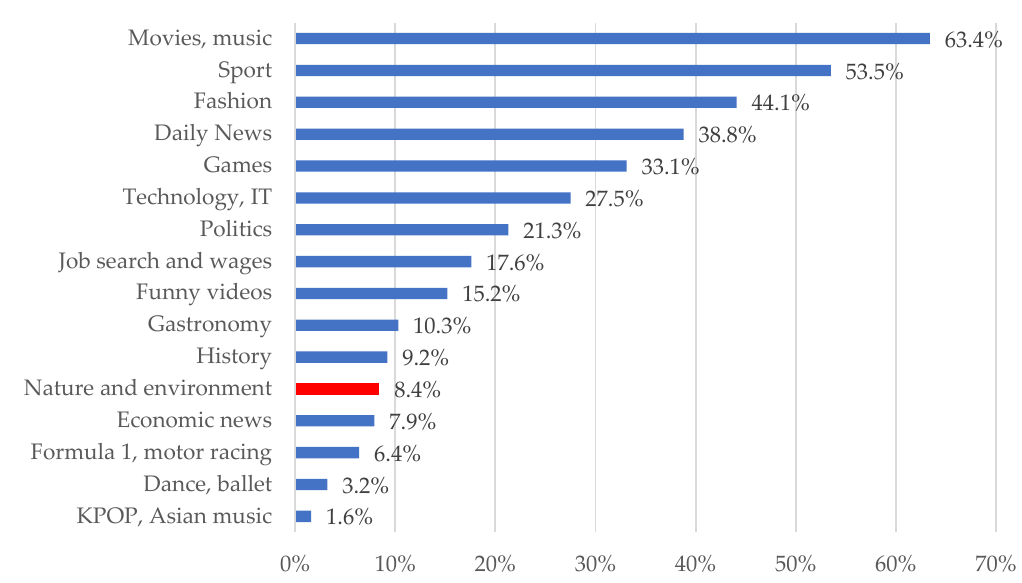
Figure 9. Distribution of students’ news reading habits on social media platforms (%).